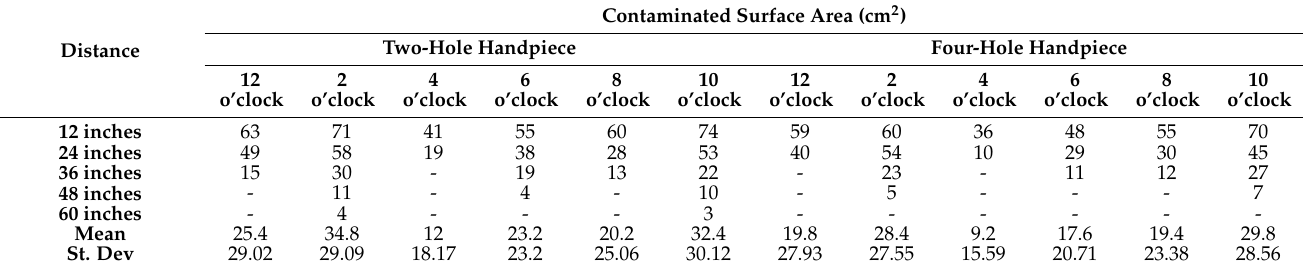
Table 1. Distribution of aerosol and splatter at different positions and distances by the two- and four-hole handpiece.